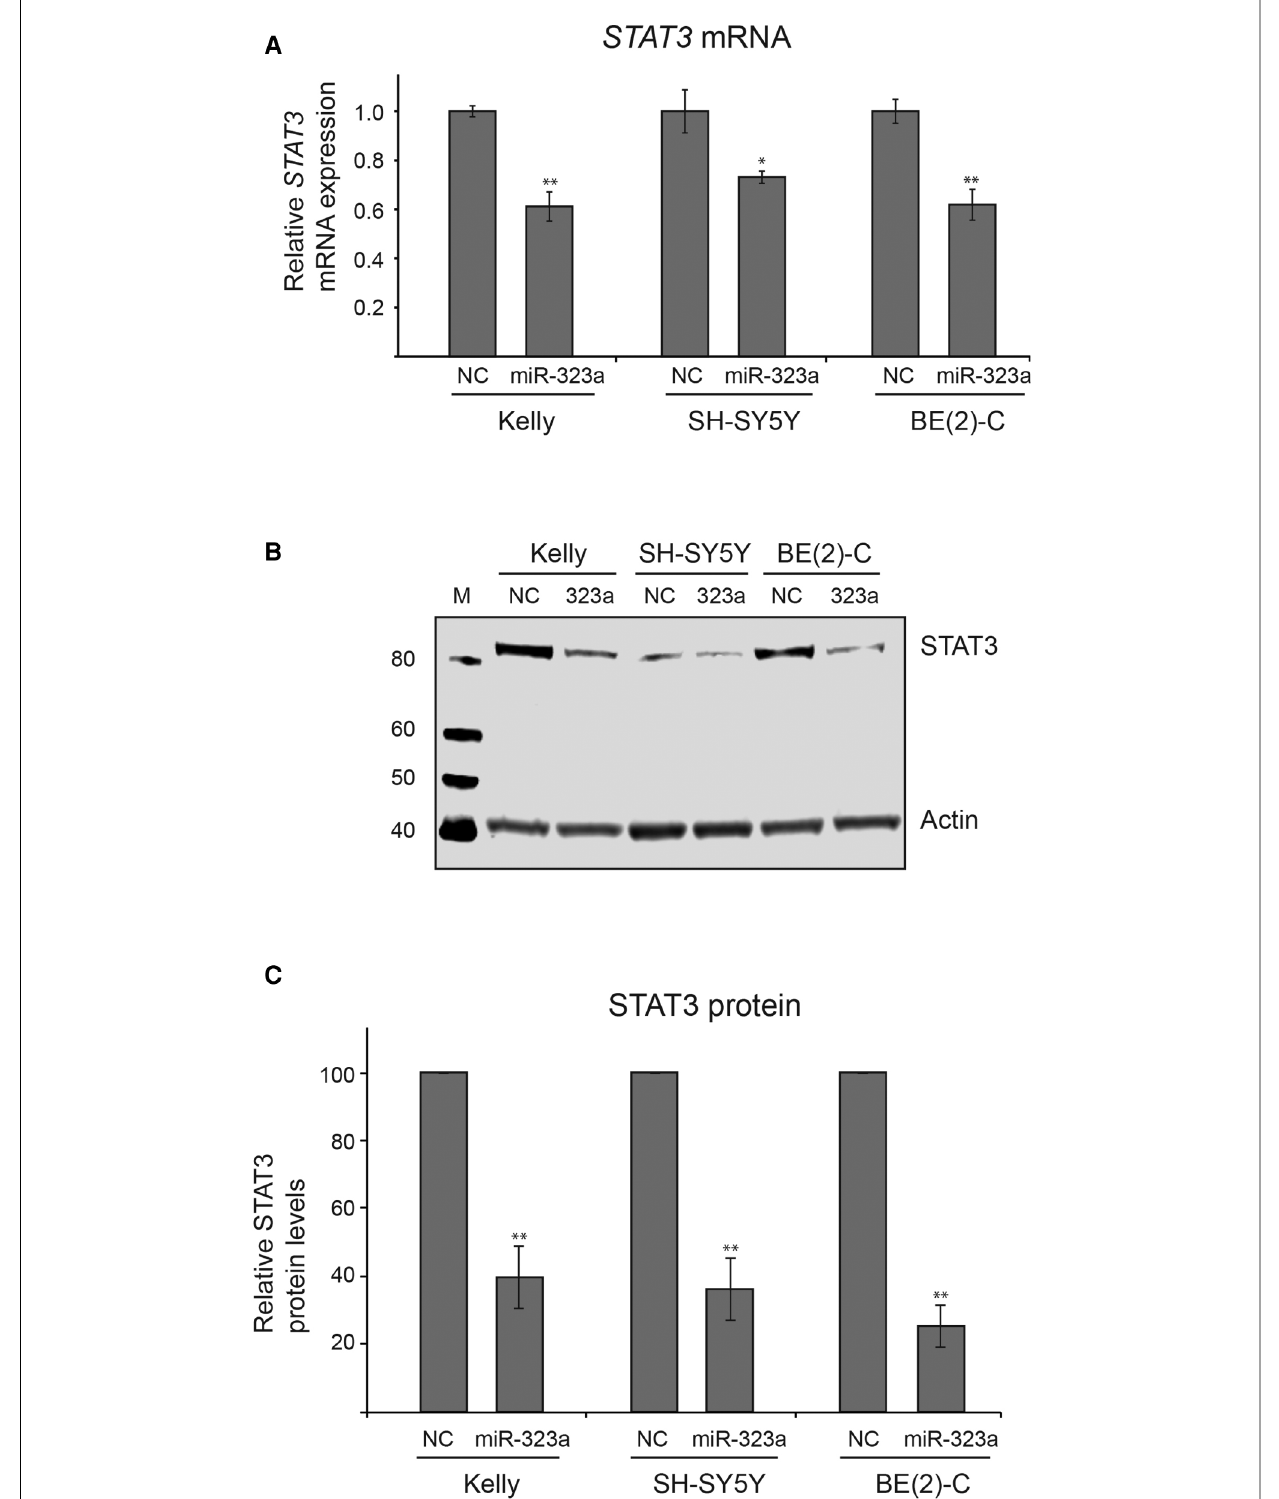
FIGURE 5 miR-323a-3p reduces mRNA and protein levels of STAT3 in neuroblastoma cells. (A) The RT-qPCR analysis of STAT3 mRNA levels in Kelly, SH-SY5Y and BE(2)-C cell lines transfected with miR-323a-3p. Data is presented as mean±SEM of three independent experiments, each repeated in triplicates. (B) Western blot assay demonstrating STAT3 protein levels in Kelly, SH-SY5Y and BE(2)-C cell lines transfected with miR-323a-3p . (C) Quanti fi cation of STAT3 protein expression on the western blots ( n =3). Data is presented as mean±SD of three independent experiments. * P <0.05, ** P <0.01 vs. the NC. RT-qPCR, reverse transcription-quantitative polymerase chain reaction; SD, standard deviation; miR, microRNA; NC, negative control; STAT3, signal transducer and activator of